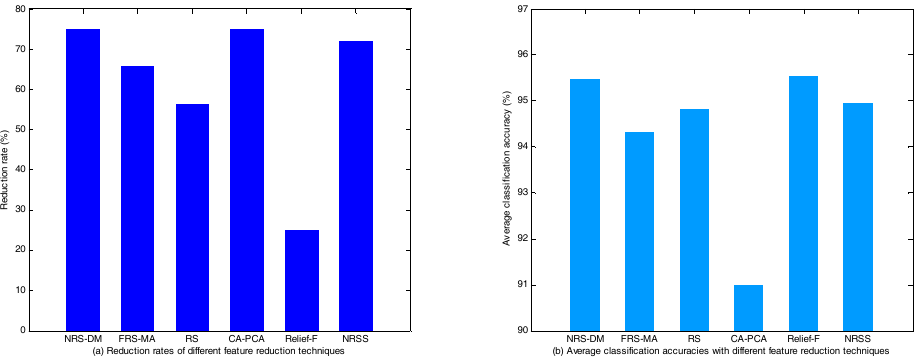
Table 5. Performance comparison of different feature selection strategies (ASS14).